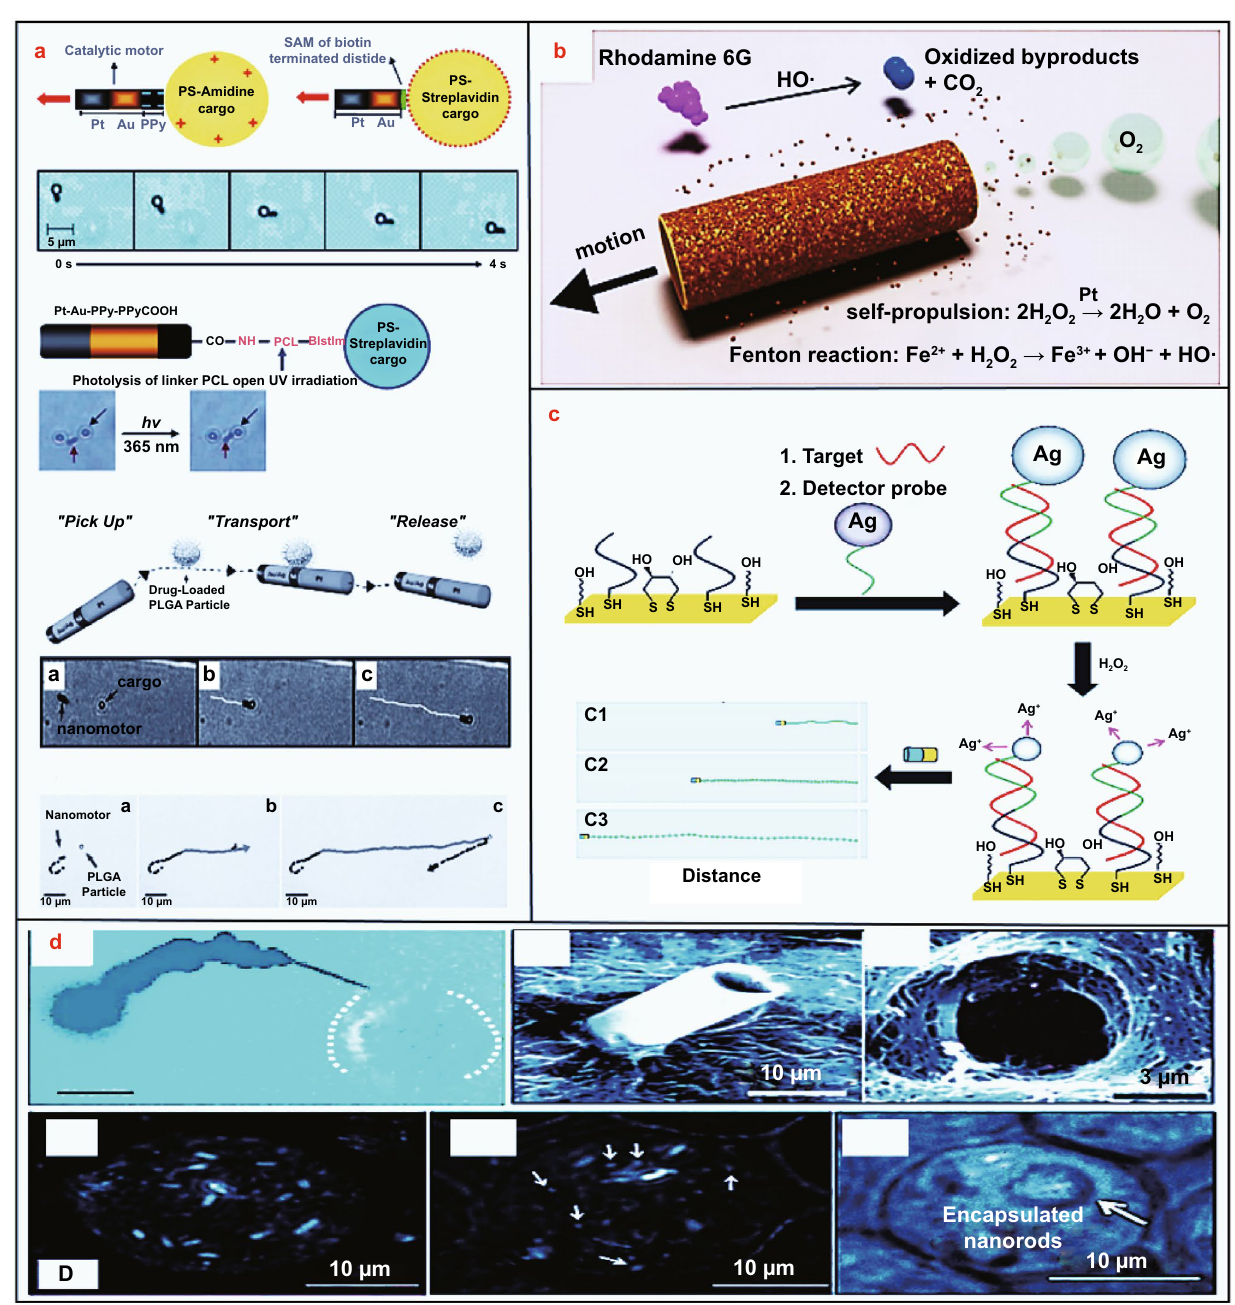
Fig. 14 a Examples of the delivery of cargo using solid micro/nanomotors: (a) cargo pick-up, (b) cargo delivery, and (c) cargo release, respec- tively. b Organic pollutants degraded by multifunctional micromotors in solutions. c Detection of nucleic acid, which alters the propulsion of the micro/nanomotors. d A catalytic nanomotor drilling into an immobilized cancer